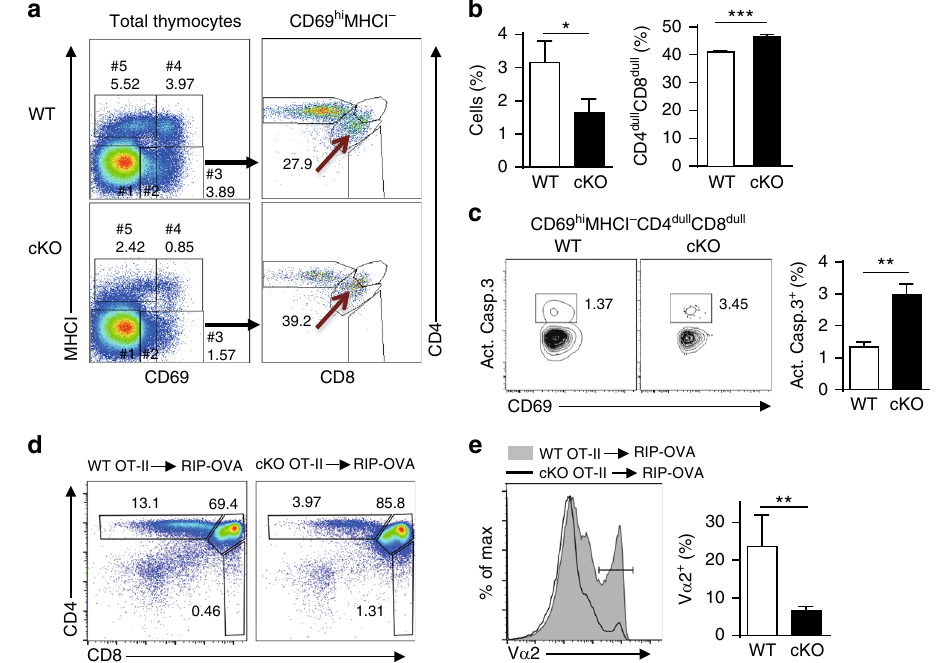
Fig. 4 NCoR1 is required to prevent excessive negative selection. a Flow cytometry analysis of 5 subpopulations (left) by MHCI and CD69 expression on total NCoR1-de fi cient (cKO) and wild-type (WT) thymocytes ( n = 3 to 5). The right panel shows CD4 and CD8 expression on gated population #3. b The proportion of population #3 (left) and CD4 dull CD8 dull subsets in population #3 (right). c Intracellular levels of Act.Casp.3 detected by fl ow cytometry in the CD69 hi MHCI − CD4 dull CD8 dull subsets from cKO and WT mice ( n = 4 to 5 for each group). d Flow cytometry analysis of CD4 and CD8 expression on total thymocytes 6 weeks after transferring bone marrow cells from OT-II TCR-transgenic cKO or WT mice into irradiated rat insulin promoter-ovalbumin (RIP-OVA) transgenic mice ( n = 4 to 5). e TCR V α 2 expression of total thymocytes from the mice in ( d ). The data are representative of three independent experiments ( a , b ) or two independent experiments ( c , d ). Statistical signi fi cance was analyzed using the two-tailed Student ’ s t test (* P < 0.05; ** P < 0.01; *** P <